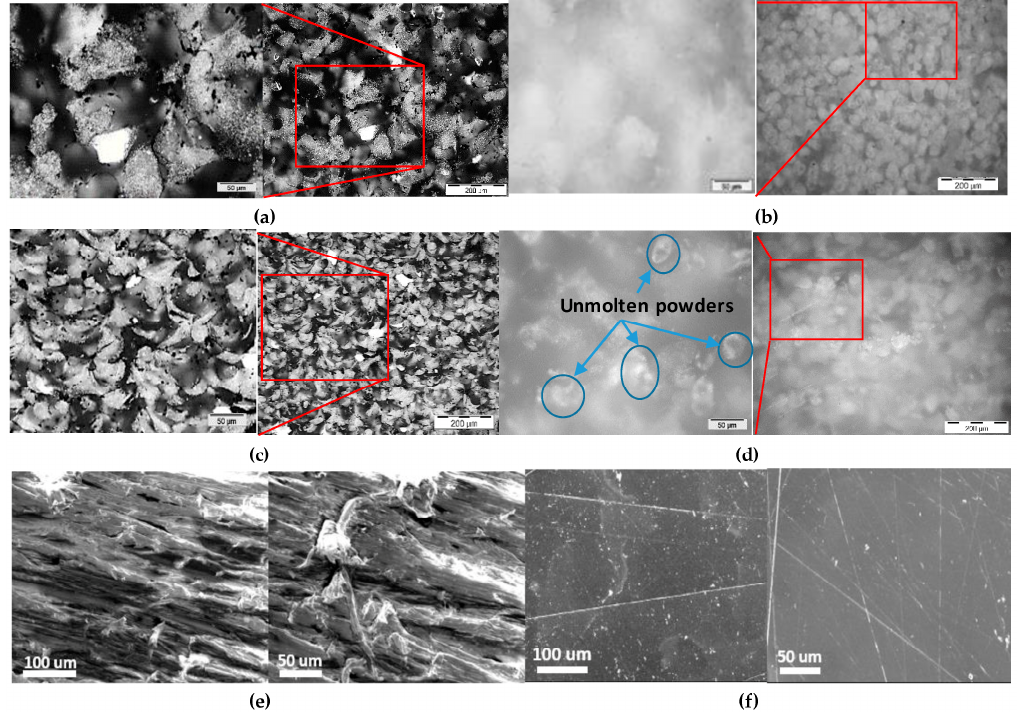
Figure 6. Optical images of microstructures of ( a ) CNTs/PA12 and ( b ) PA12 from the X – Y plane; ( c ) CNTs/PA12 and ( d ) PA12 specimen cross-section from the X – Z plane and the molten powders highlighted. SEM images of surface structures of ( e ) CNTs/PA12 and ( f ) PA12 through mechanical grinding and polishing.